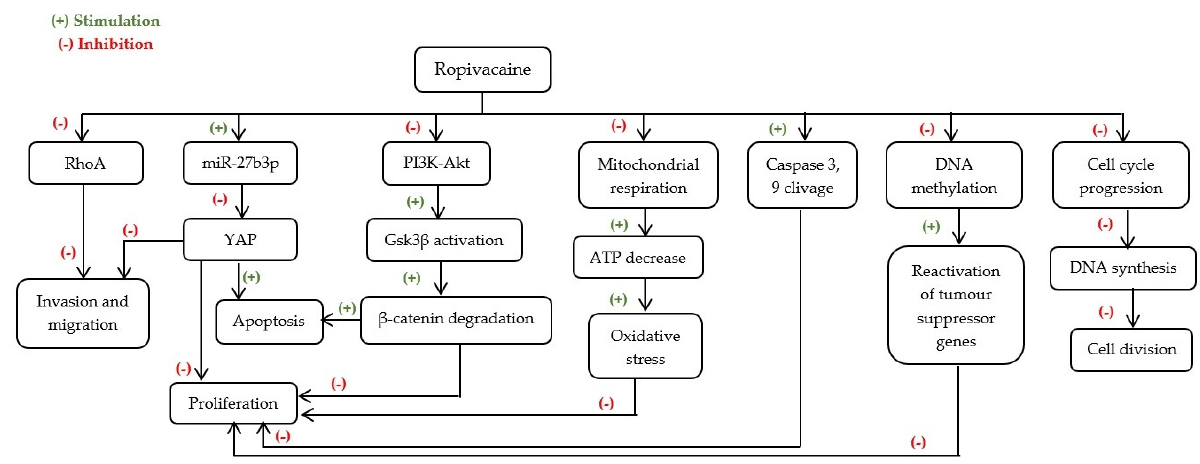
Figure 3. Possible mechanisms underlying ropivacaine’s anti-cancer effects. ATP—Adenosine triphosphate; DNA—Deoxyribonucleic acid; Gsk3 β —Glycogen synthase kinase 3 beta; miR-27b3p— microRNA-27b3p; PI3K-Akt—Phosphatidylinositol 3-kinase—Protein kinase B; RhoA—Ras homolog family member A; YAP—Yes-associated protein.